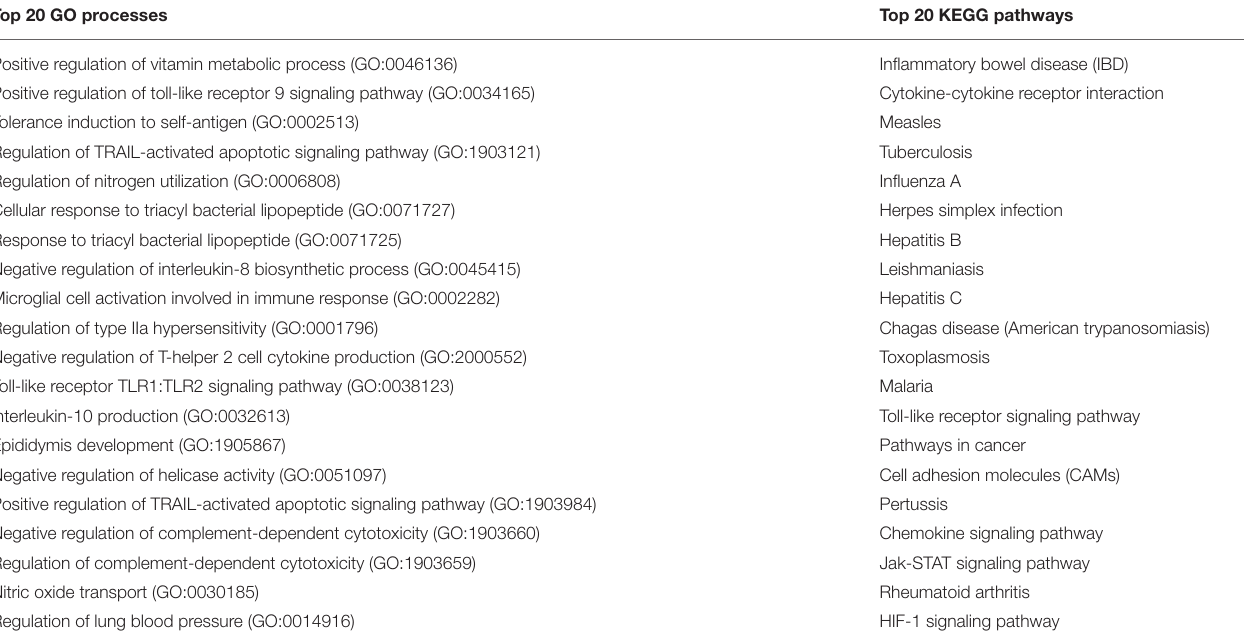
TABLE 9 | Top 20 GO processes and KEGG pathways related to the selected 680 gut-immune genes involved in protection from injurious or allergenic